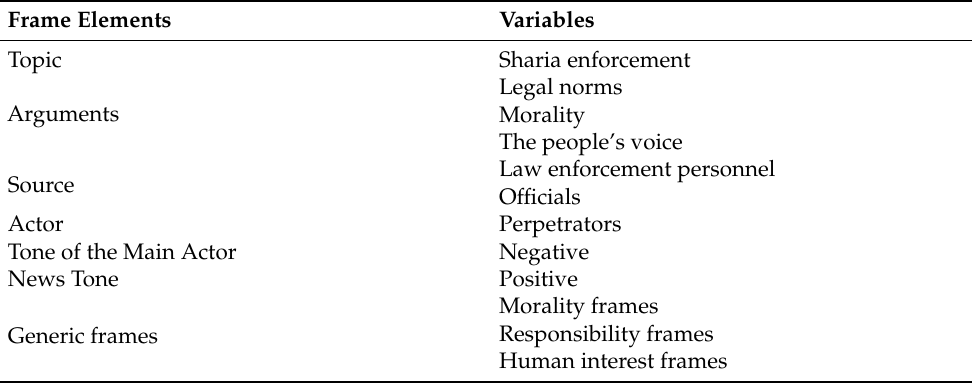
Table 4. The desirable Sharia enforcement